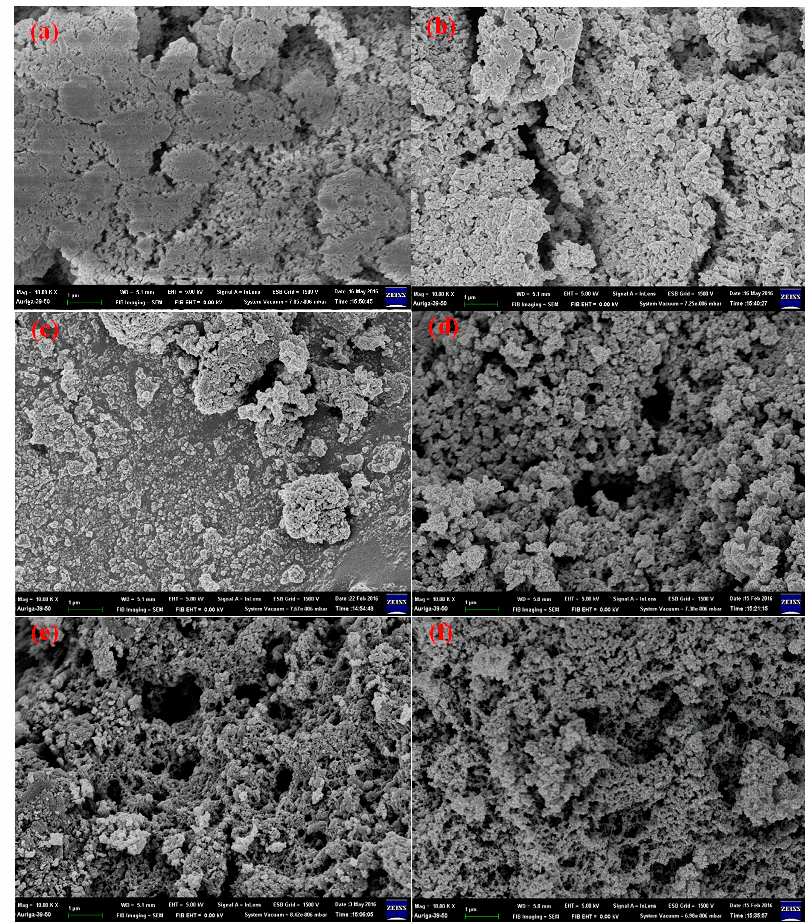
Figure 3. SEM images of Pt/EB-XC72 treated at different temperatures. ( a ) Neat EB-XC72, ( b ) PtCl 62 − /EB-XC72 at RT, ( c ) 500 °C, ( d ) 600 °C, ( e ) 800 °C, and ( f ) 900 °C.